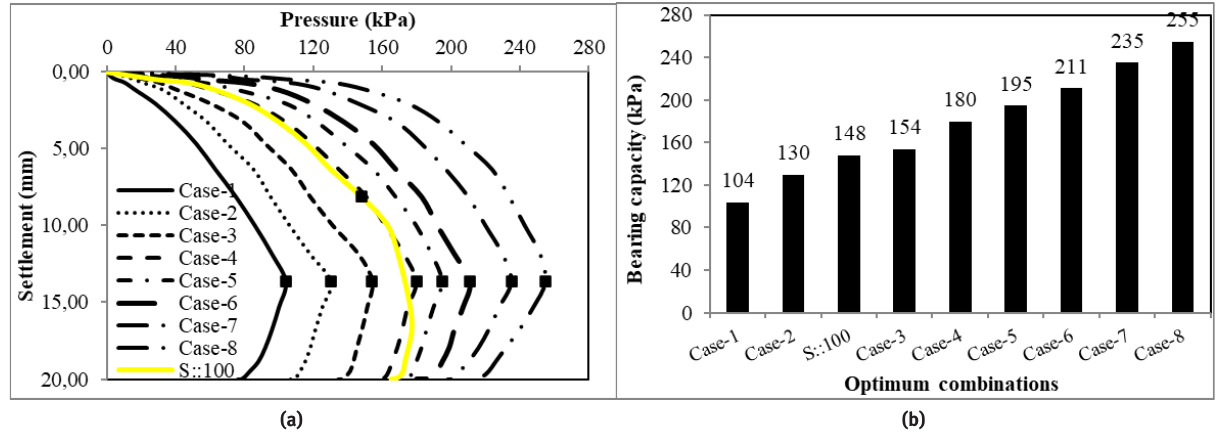
Figure 9:(a) Pressure–settlement curves and (b) bearing capacity values of two-layered soil for all cases at h/B=1.75 and of single-layer sandy soil for